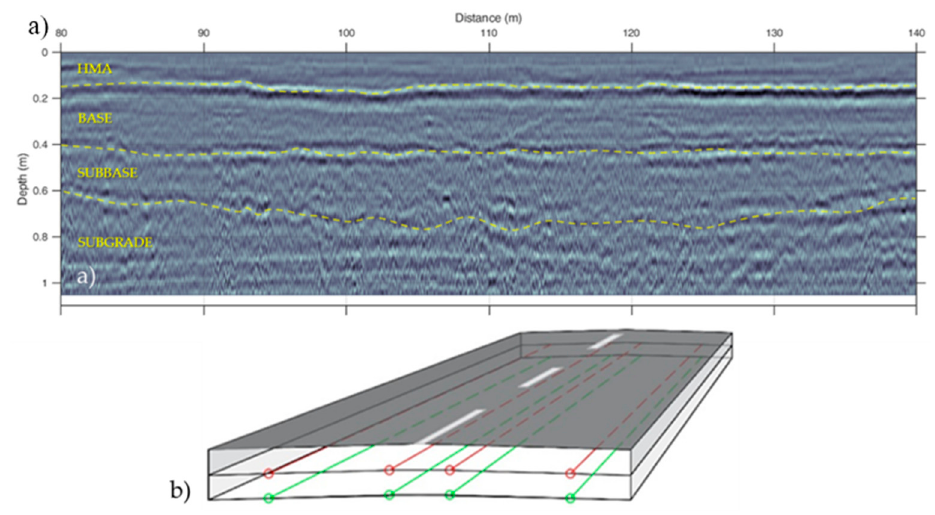
Figure 8. ( a ) example of GPR scan extracted by the survey dataset with evidenced the interfaces between the layers; ( b ) 3D polylines generated from the management of GPR